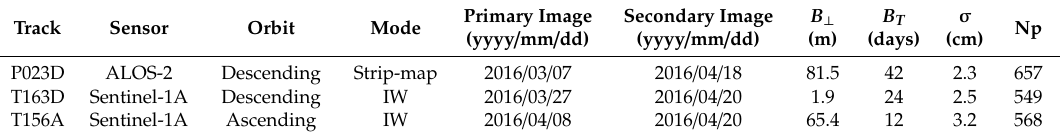
Table 1. Synthetic aperture radar (SAR) interferometric pairs used in the